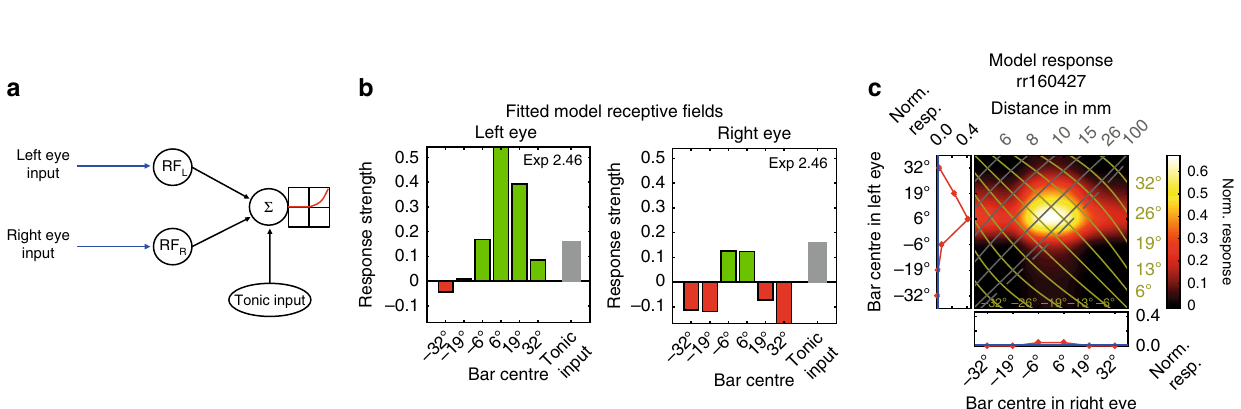
Fig. 2 Linear-nonlinear model. a Outline of linear-nonlinear model components. Visual inputs are fi ltered by left-and right-eye receptive fi elds, then summed linearly along with tonic input, followed by spiking threshold and power-law. b Fitted left and right receptive fi elds for TAOpro-neuron; green = excitation, red = inhibition, grey = tonic input (shown in both RF plots, but applied only once), exponent in upper right corner (exp). c Fitted model responses for TAOpro-neuron